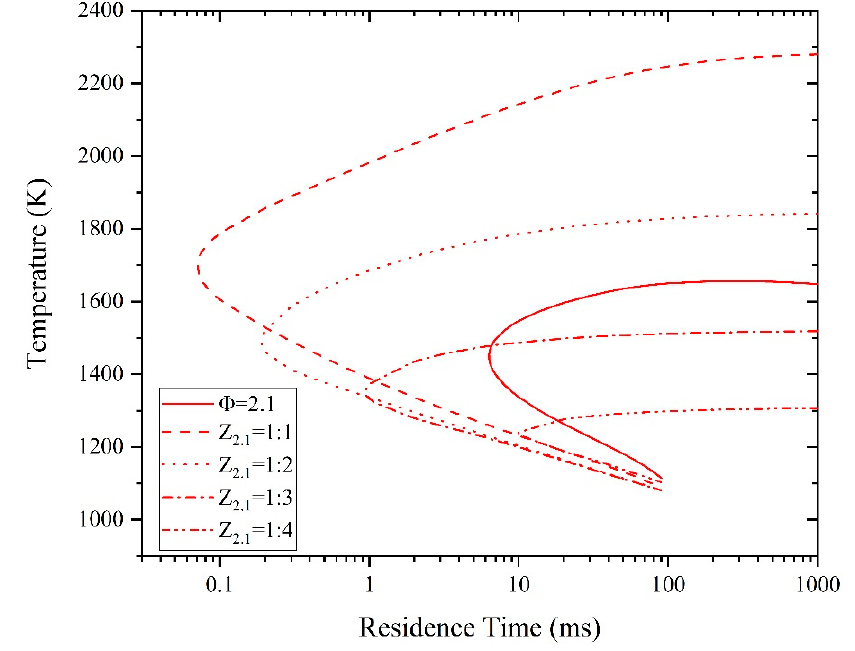
Figure 12. Comparison of C-curves of n -pentane at an equivalence ratio of 2.1 and air–light hydrocarbon mixing gas at mixing degree of 1, 1/2, 1/3, and 1/4, respectively.